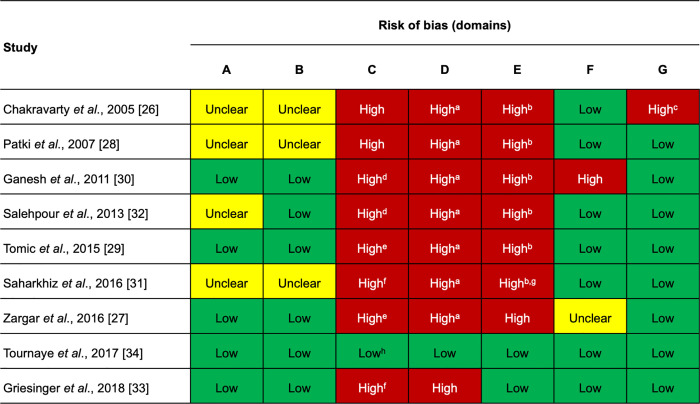
Risk of bias for the eligible studies.Risk of bias legend: A = random sequence generation; B = allocation concealment; C = blinding of participants and personnel; D = blinding of outcome data; E = incomplete data; F = selective reporting; G = other bias. ahigh risk of bias was expected for the assessment of adverse events; the risk of bias was lower for efficacy outcomes due to the objective methods of assessment. bA high risk of bias was expected for the reporting of adverse events. cStudy contained a larger proportion of women > 40 years of age in the oral dydrogesterone group. dSingle-blind study. eDouble-blind study, but patients were aware of the treatment arm due to the different routes of administration and the lack of use of a placebo dummy. fOpen-label study. g10.3% participants were excluded after randomization, and the numbers lost to follow-up were unbalanced between treatment groups. hDouble-blind, double-dummy study.